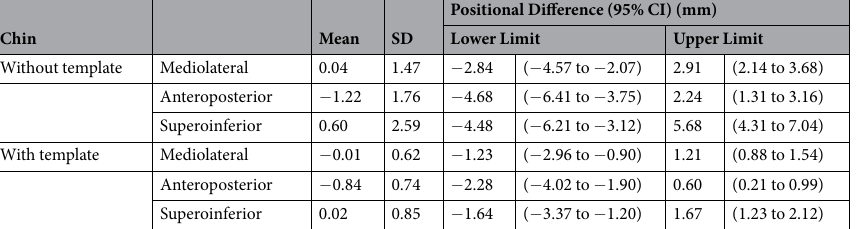
Table 2. Bland-Altman’s Accuracy Estimate of Positional Differences between the Planned and Postoperative Outcomes (mm).